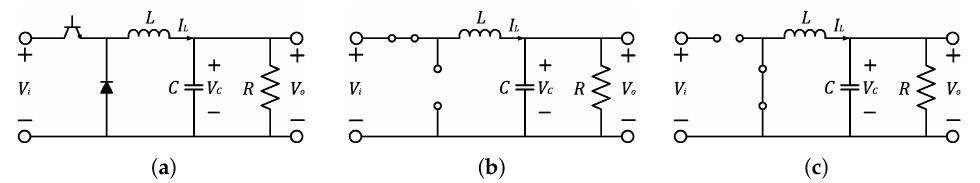
Figure 1. ( a ) Buck converter circuit. ( b ) Buck converter circuit for switched on condition. ( c ) Buck converter circuit for switched off